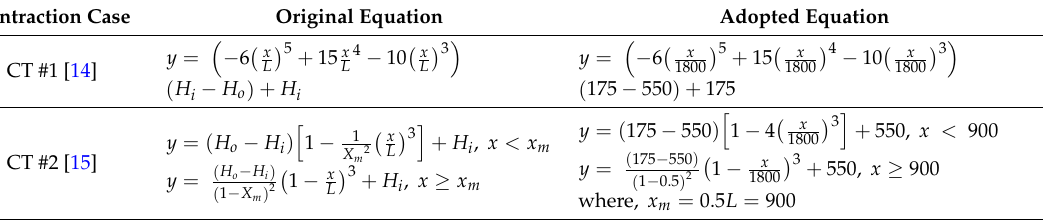
Table 1. Equations for four investigated contraction (CT) wall shapes.